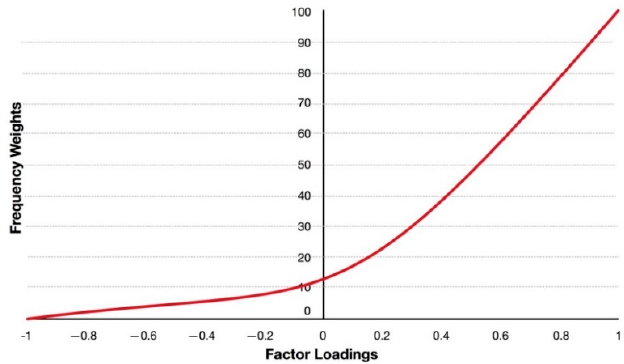
Figure 3. Proposed curve for calculating the frequency weight (FW) in each behavior at Level 2.